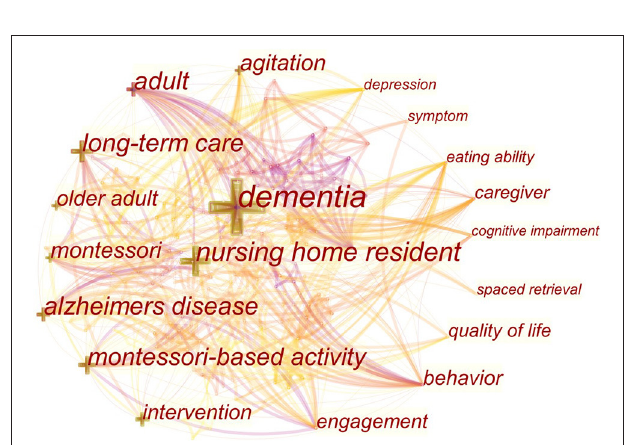
FIGURE 6 | Keyword co-occurrence graph of articles published in English on Montessori approach to interventions for patients with dementia from 2000 to